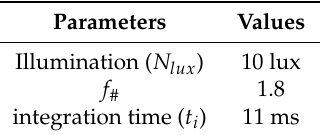
Table 6. Exposure parameters.